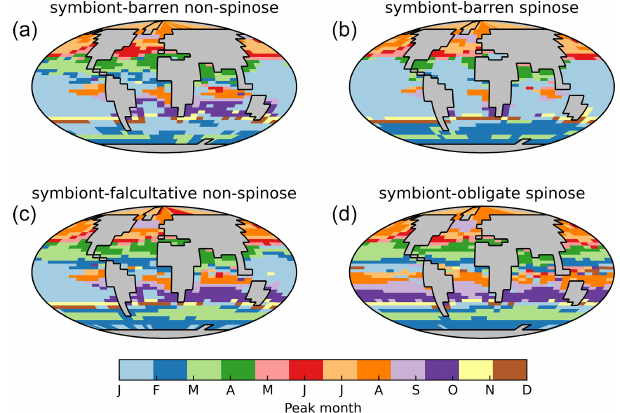
Figure 8. Global ForamEcoGEnIE 2.0 estimates for (a) sur- face foraminiferal calcite flux (at 80.8m; mmolCm − 2 yr − 1 ) and (b) groups contribution.